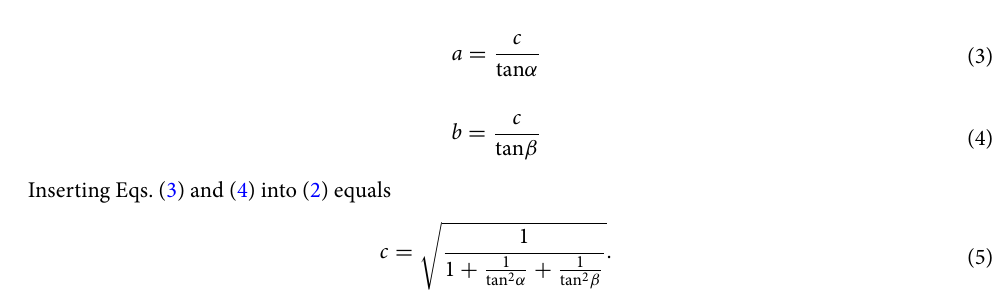
Figure 3. Prism design, actuation, and geometric relation. ( A ) An arrangement of the servos and rings that hold the prism (upside down). ( B ) Kinematic of the adaptive prism. View from below. ( C ) Prism design. ( D ) Kinematic model of one servo bearing. Front view. ( E ) Relationship between angles and coordinates that describe the glass plate with respect to the XY